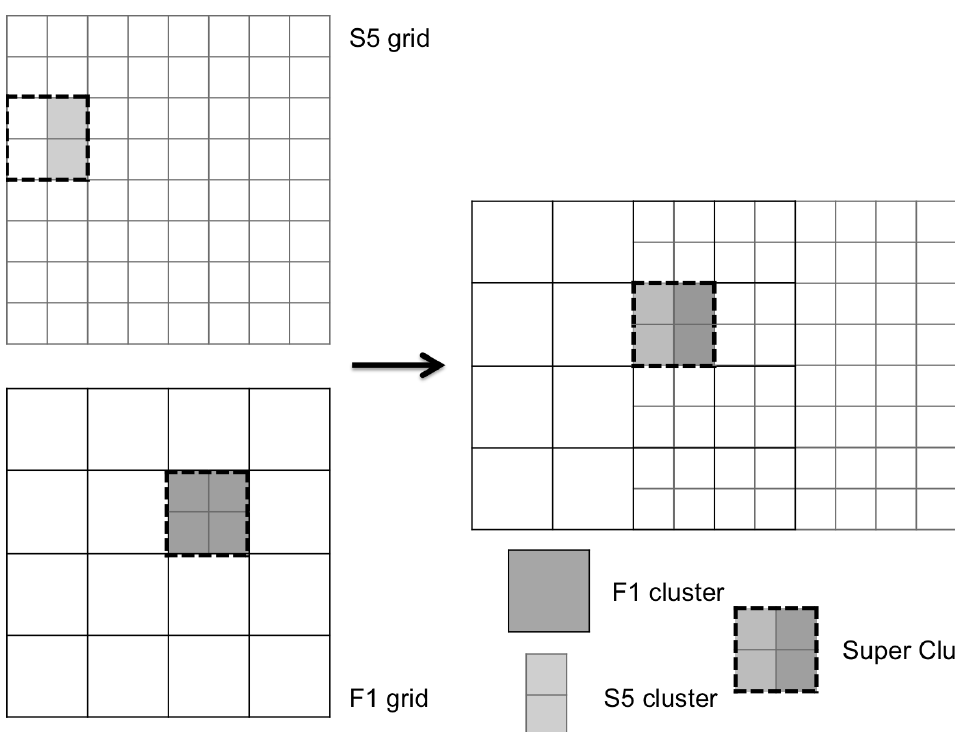
Figure 6. Super cluster